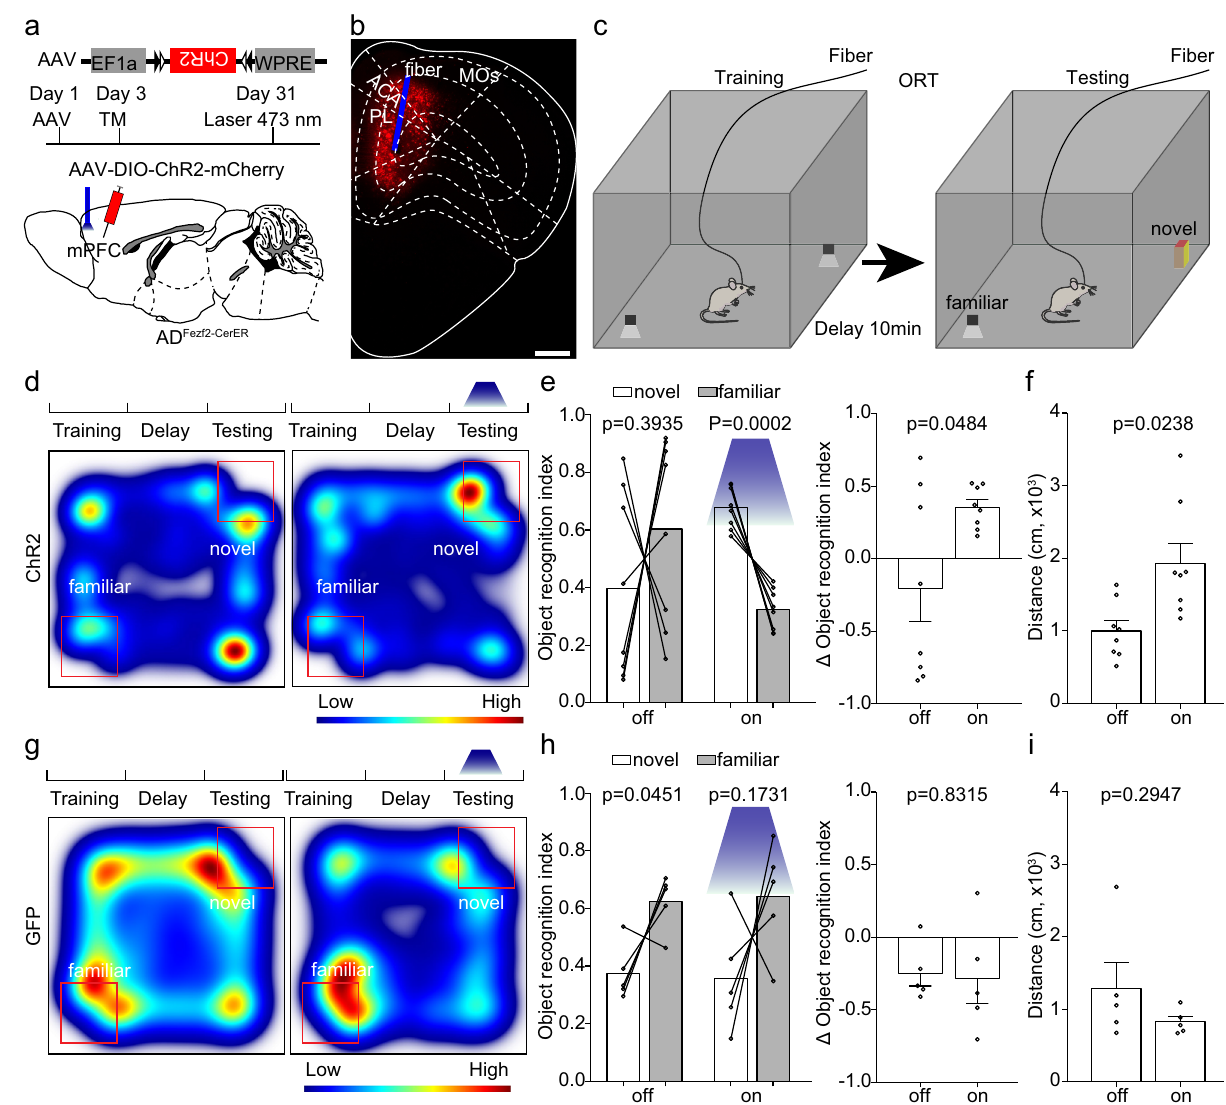
Fig. 2 Activation of extratelencephalic projection neurons in the mPFC of 5×FAD mice improved the object recognition memory expression. a The experimental strategy of activation of extratelencephalic projection neurons in the mPFC. b An example of position of optical fi ber for activation of the extratelencephalic projection neurons in the mPFC. c The experimental procedure of novel object recognition test. d Heat-map plots showed object recognition memory measures from the object recognition test. Red = more time, blue = less time. The heatmap in the left and right showed examples of AD Fezf2-CreER mice that expressed ChR2 in the ET neurons in the mPFC exploring the familiar object and novel object during the test session without or with light stimulation, respectively. e Statistical plots of object recognition index and delta object recognition index in laser off and laser on sessions. (left and right, two-tailed paired t test). n = 8 animals for each group. f Statistical plots showed the traveling distance during the test session with or without light stimulation. two-tailed paired t test; n = 8 animals. g The heatmap in the left and right showed examples of AD Fezf2-CreER mice that expressed GFP in the ET neurons in the mPFC exploring the familiar object and novel object during the test session without or with light stimulation, respectively. h Statistical plots of object recognition index and delta object recognition index in laser off and laser on sessions. (left and right, two-tailed paired t test). n = 5 animals. i Statistical plot showed that the light stimulation in control group that expressed GFP did not alter the traveling distance during the test. two-tailed paired t test, n = 5 animals. Scale bar in b is 500 μ m. All data are listed as the Mean ± SEM. ACA anterior cingulate area, PL prelimbic area, MOs secondary motor area, TM